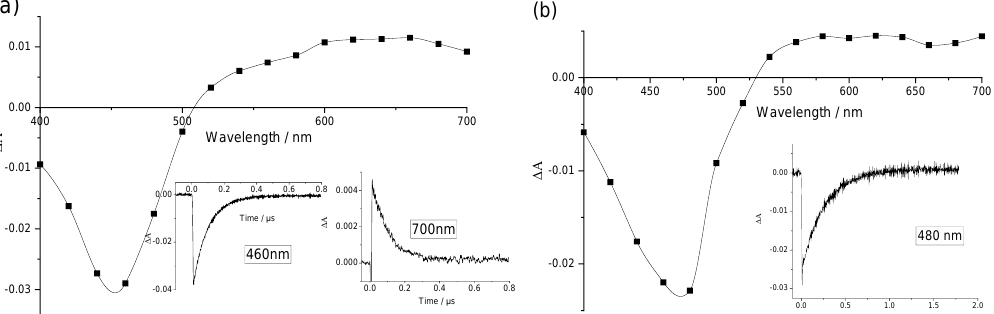
Figure 6. ( a ) Differential triplet–triplet absorption spectrum for 4Met-BAC (8.0 × 10 − 6 M) in acetonitrile (air-equilibrated) at 35 ns after flash. Excitation at 455 nm. Inserts show photobleaching of the singlet state at 460 nm and decay of the triplet state of 4Met-BAC at 700 nm ( k = 1.1 × 10 7 s − 1 ). ( b ) Differential triplet–triplet absorption spectrum for 4Met-BAC (8.0 × 10 − 6 M) in propanol-1 (air-equilibrated) at 50 ns after flash. Excitation at 475 nm. Insert shows 4Met-BAC singlet state photobleaching at 480 nm ( k = 3.8 × 10 6 s − 1 ).